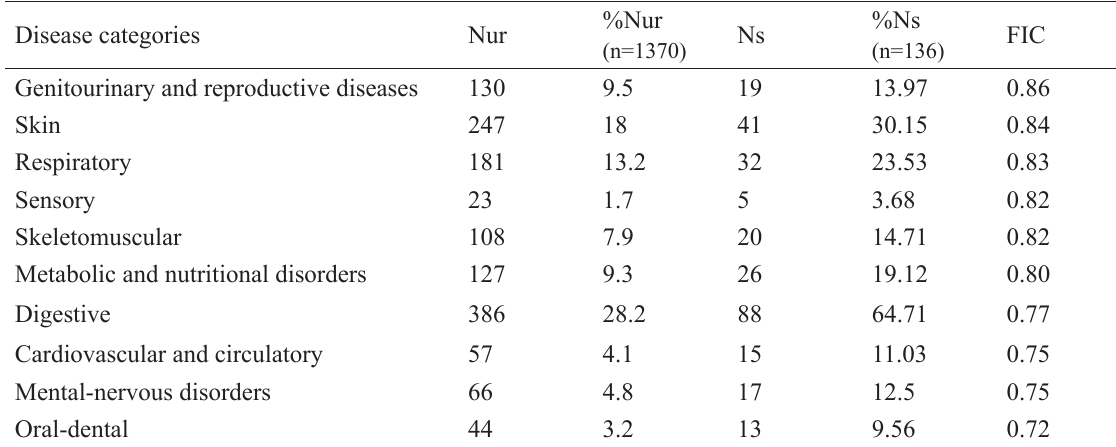
Table 6. Categories of diseases, number of use reports (Nur), percentage of use reports (%Nur), number of species (Ns), percentage of species (%Ns), and their factor of informant consensus (FIC) values. Disease